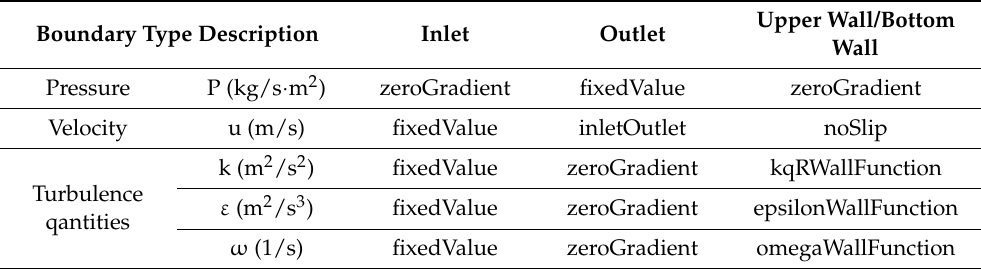
Table 6. Boundary conditions of the backward-facing step in the turbulent